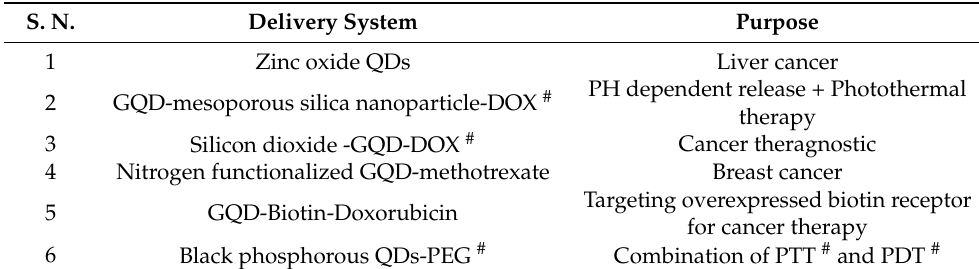
Table 8. Applications of QDs in drug delivery for augmented cancer therapy. Reproduced with permission from reference